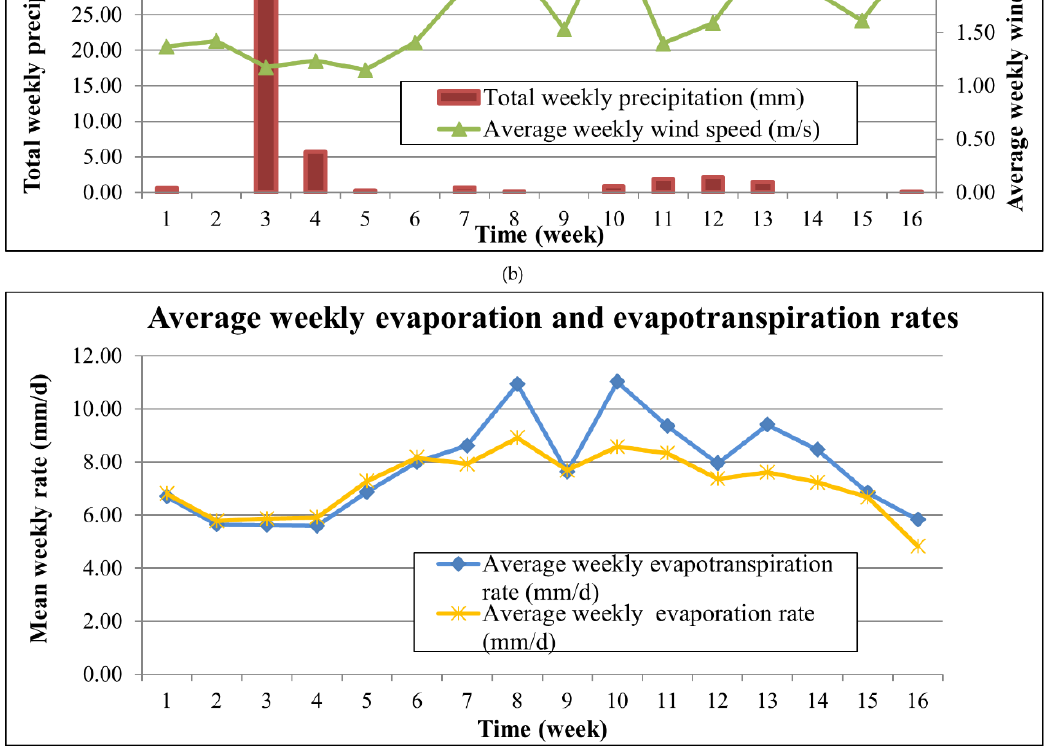
maximum 34.5 °C. The mean daily temperature for the study period was 27.1 °C, whereas